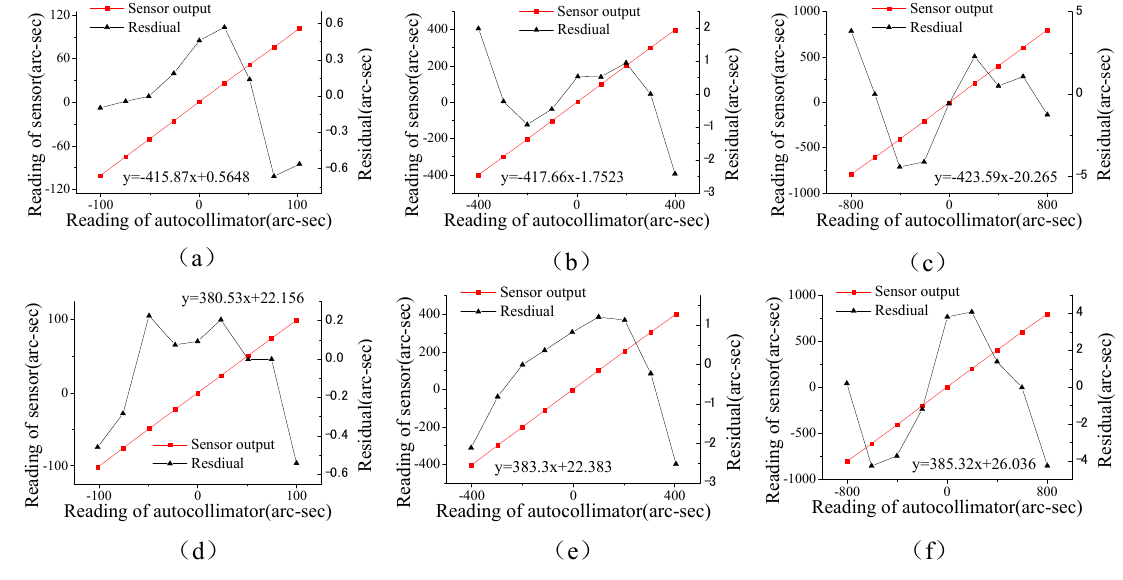
Figure 6. Calibration results of the dual-axis precision level: ( a ) ε x in ± 100 arc-sec; ( b ) ε x in ± 400 arc-sec; ( c ) ε x in ± 800 arc-sec; ( d ) ε y in ± 100 arc-sec; ( e ) ε y in ± 400 arc-sec; ( f ) ε y in ± 800 arc-sec.